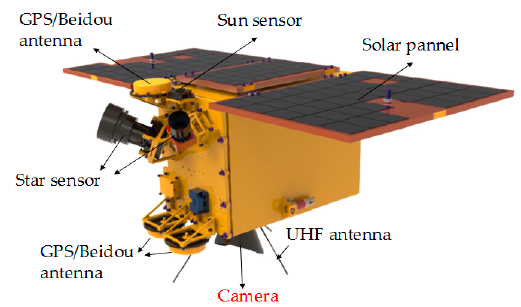
Figure 1. Luojia 1-01 satellite.